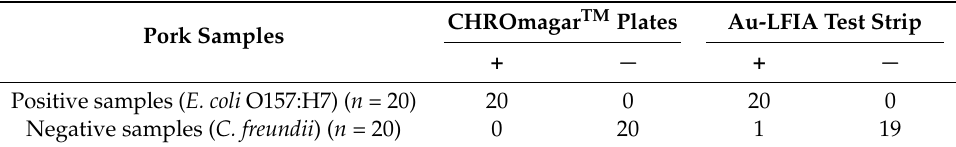
Table 3. Evaluation of modified CT-SMAC in ground pork